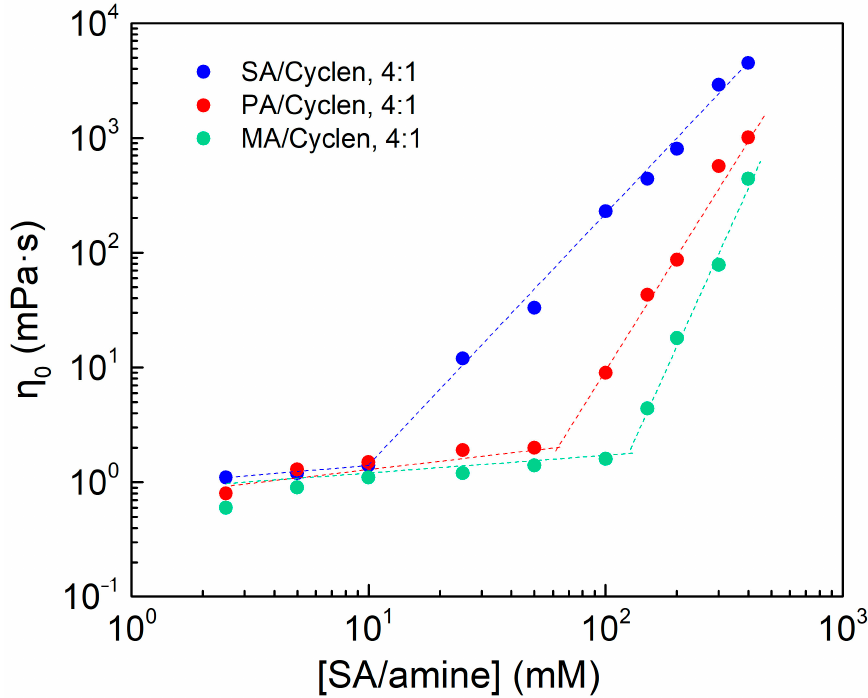
Figure 9. The effect of concentration on viscosity of long-chain carboxylic acid/cyclen at 25 °C, the shear rate is 10 s − 1 .